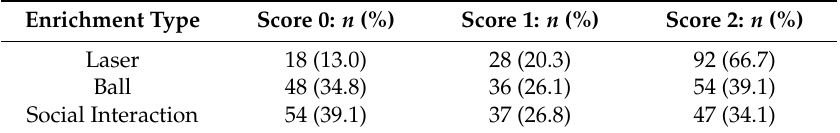
Table 1. Interest scores for laser, ball, and social interaction across the 138 trials. The number of trials at each score, and the percentage of the total trials is shown for each enrichment type. A score of 0 indicates no interest, while a score of 2 indicates high interest.